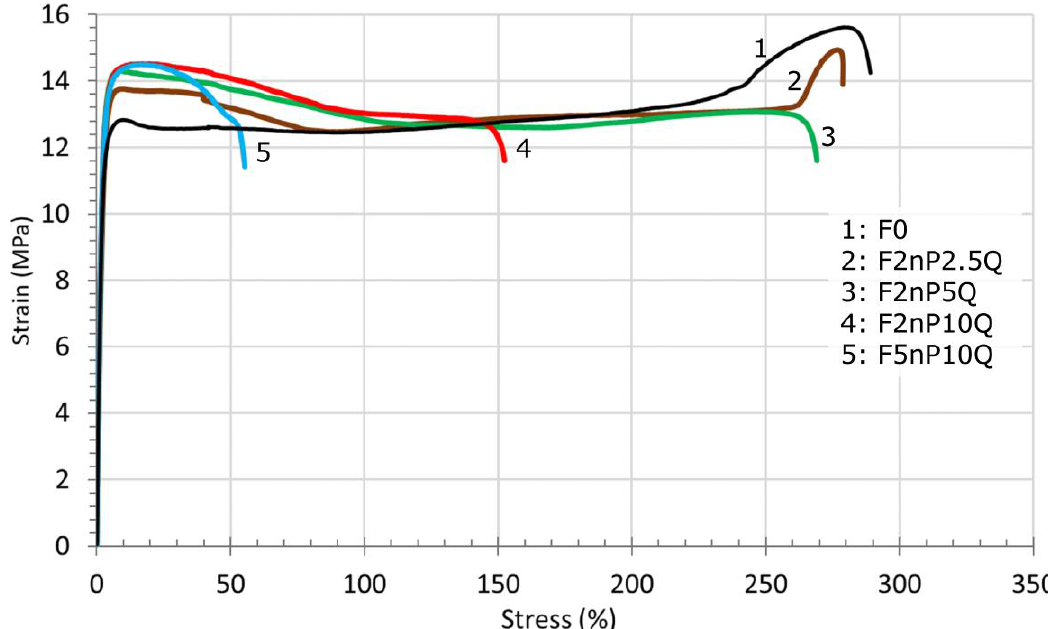
Figure 6. Tensile stress-strain curves of unfilled FEP and FEP-based composites.